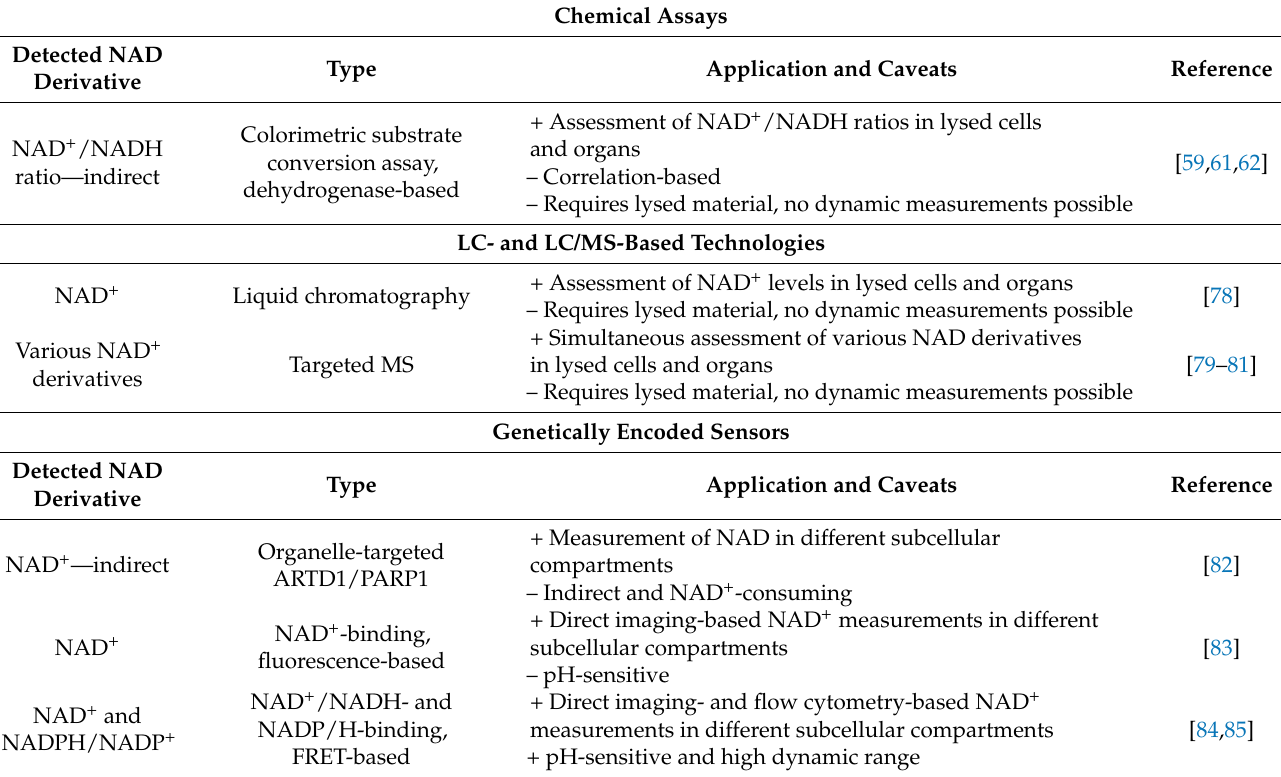
Table 1. Overview on currently available NAD detection